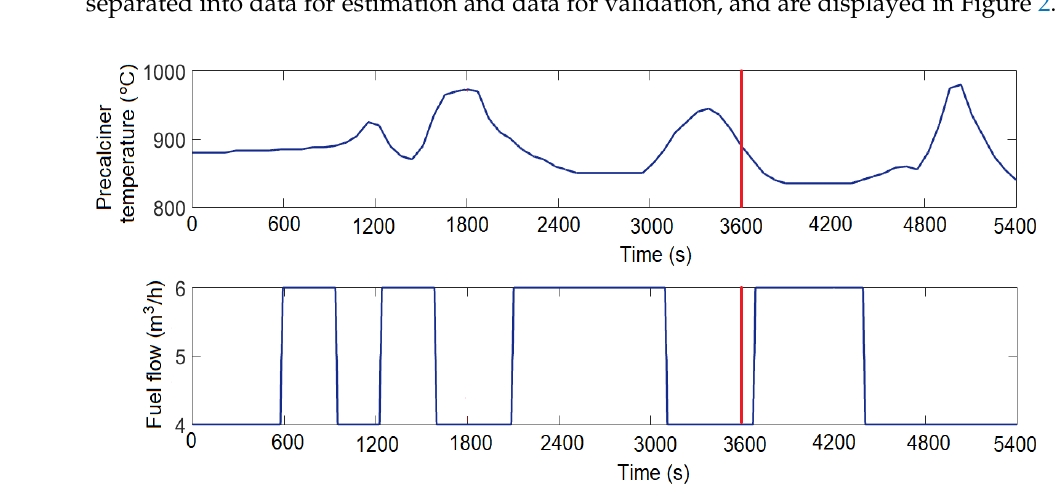
Figure 2. Results of the experiment with a pseudo-random binary sequence (PRBS).